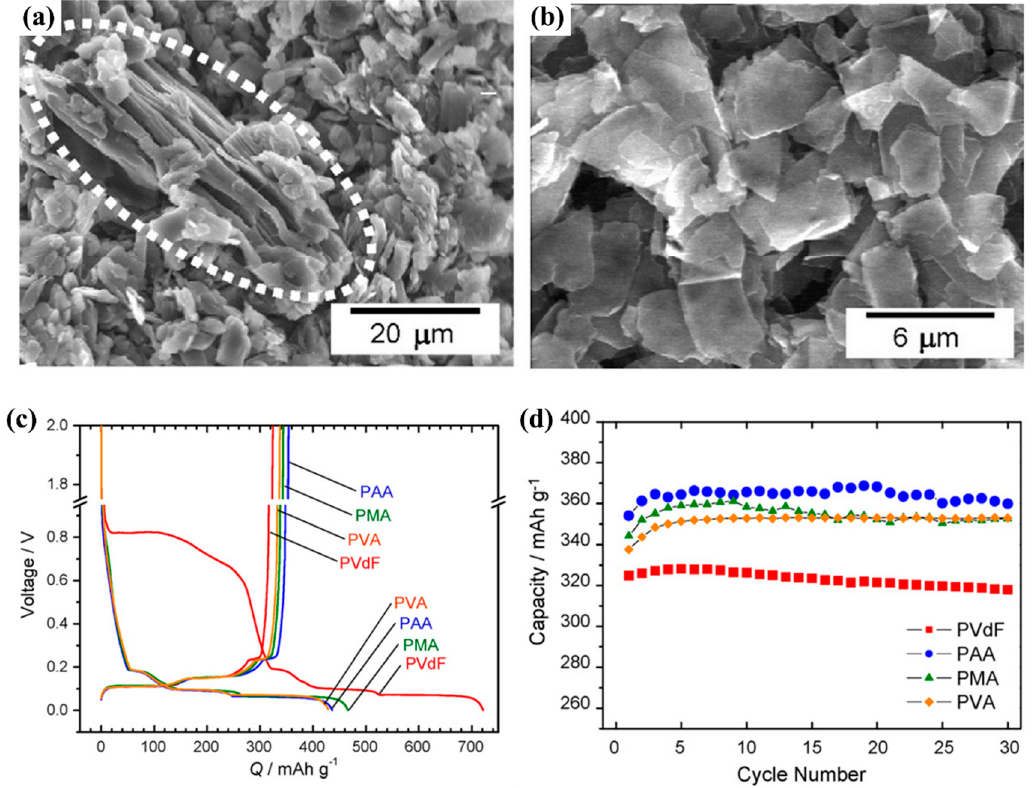
Figure 3. SEM images of Gr electrodes with ( a ) PVDF after the first cycle in LiClO 4 in PC. The partial exfoliation of Gr was confirmed. ( b ) PAA after the first cycle in LiClO 4 in PC. ( c ) First charge/discharge curves of Gr electrodes with different binders in LiClO 4 in PC. The discharge curves have different behaviors for the PVDF electrode, and a noticeable plateau can be seen around 0.8–0.6 V because of enormous co-intercalation causing decomposition of PC molecules, which caused the exfoliation of Gr. ( d ) Cycling stability of Gr electrodes with various binders in LiClO 4 in PC electrolyte. The weight % of polymers in the electrodes: PVDF (10%), PAA (15%), PMA (15%), or PVA (5%) in N-Methyl-2-pyrrolidone (NMP). Charge/discharge cycles of the Gr electrode at 50 mA g − 1 between 0.0 and 2.0 V vs. Li/Li + at 25 °C. Reproduced from Ref [9] with permission from Elsevier.